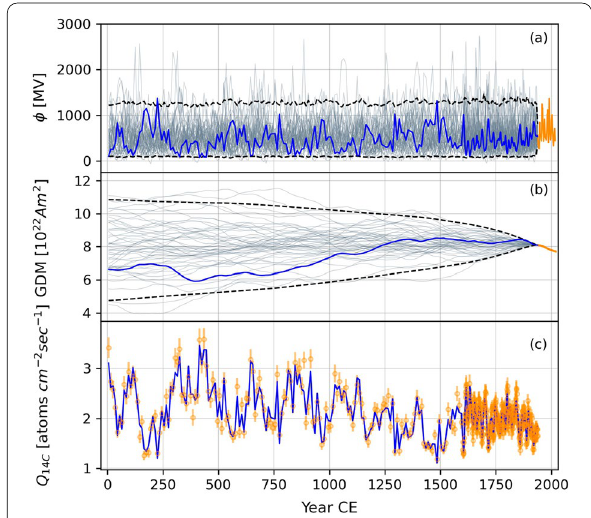
Fig. 7 Prior distributions of φ and GDM, and the synthetic 14 C data generated from the distributions. a and b Show the prior distributions of the solar activity and GDM, respectively. The grey lines depict 50 random realizations and the two black dashed lines indicate 2-sigma uncertainty of a thousand realizations. The orange lines represent the recent observations to which the model is connected, i.e., φ HE16 and GDM based on COV-OBS. 2. The blue lines × represent the selected realization used to generate the synthetic 14 C production rate. c Shows the synthetic 14 C production rate (blue line) and the resampled values with 6.7% standard error (orange circles with error